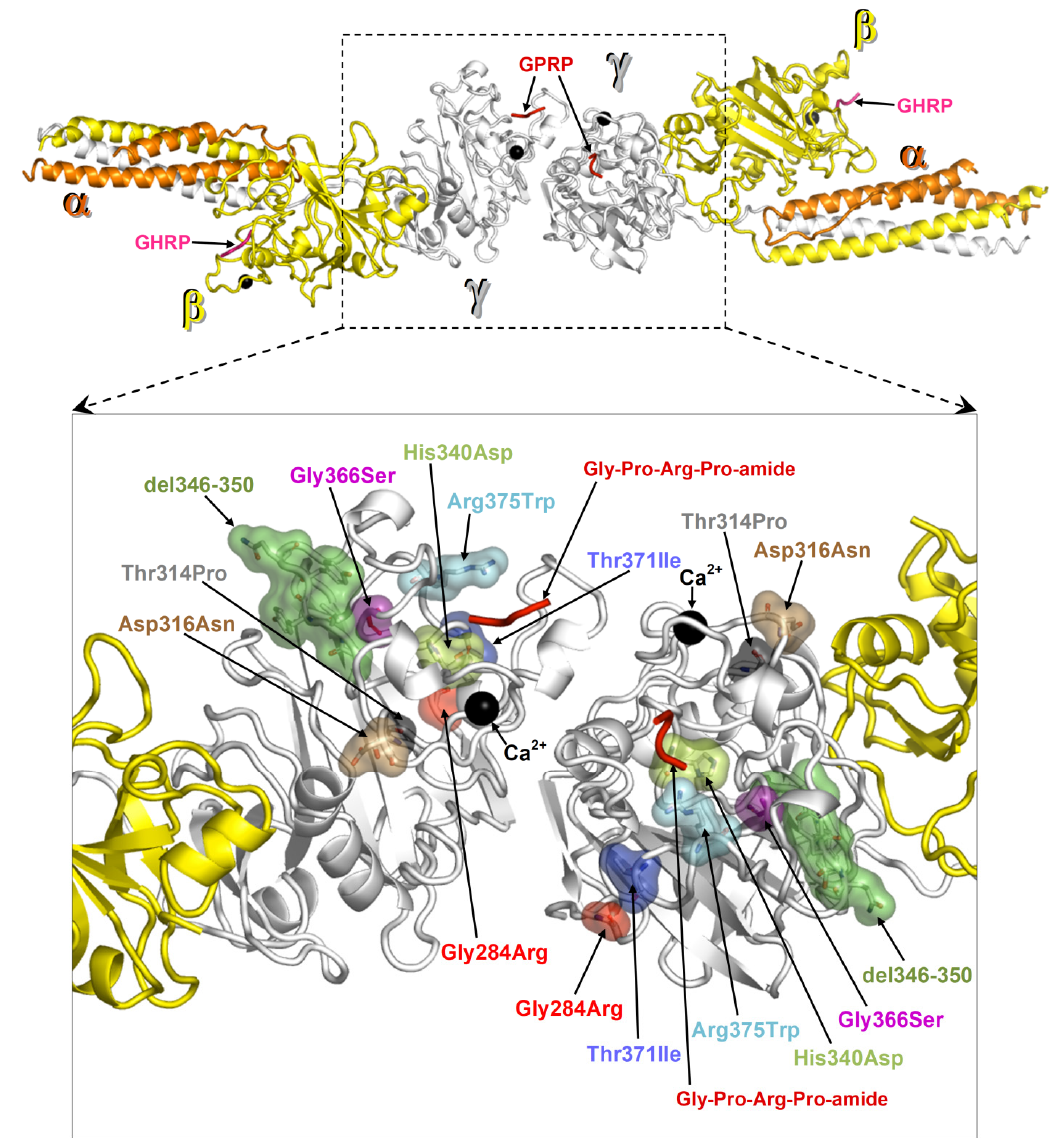
Figure 2. Map of fibrinogen γ chain mutations on the structure of fragment double-D. Structure of fragment double-D from human fibrin Protein Data Bank (PDB 1FZC) with the amino acid residues affected by mutations known to cause fibrinogen hepatic storage. The bound calcium ions are shown as black spheres, the peptide Gly-Pro-Arg-Pro-amide (GPRP, an analogue of the α chain “knob”) bound to the “hole” of γ chains is represented in red ribbons, and the peptide Gly-His-Arg-Pro-amide (GHRP, an analogue of β chain “knob”) bound to the “hole” of β chains is in viola